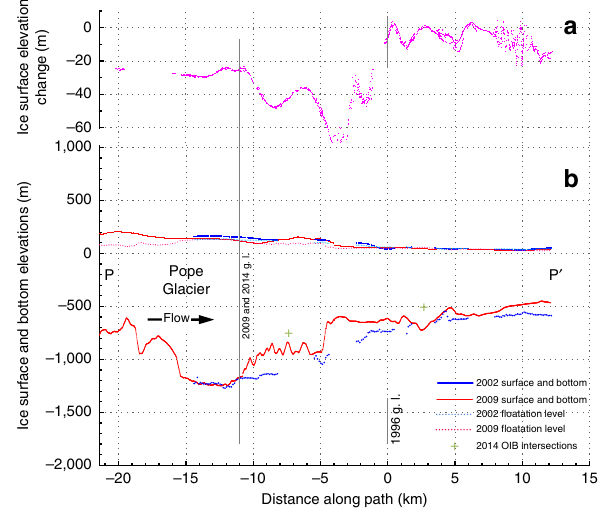
Figure 4 | Kohler Glacier radar transects showing basal ice losses and corresponding surface elevation changes between the years 2002 and 2009. ( a ) Surface elevation change between 2002 and 2009 as measured by ATM laser altimetry on the along-flow Kohler Glacier (KG) transect delimited by K-K 0 shown in Fig. 1a. ( b ) The 2002 and 2009 ice surface and bottom MCoRDS profiles of KG along the transect delimited by K-K 0 in Fig. 1a. The hydrostatic floatation levels were found as described in the caption of Fig.